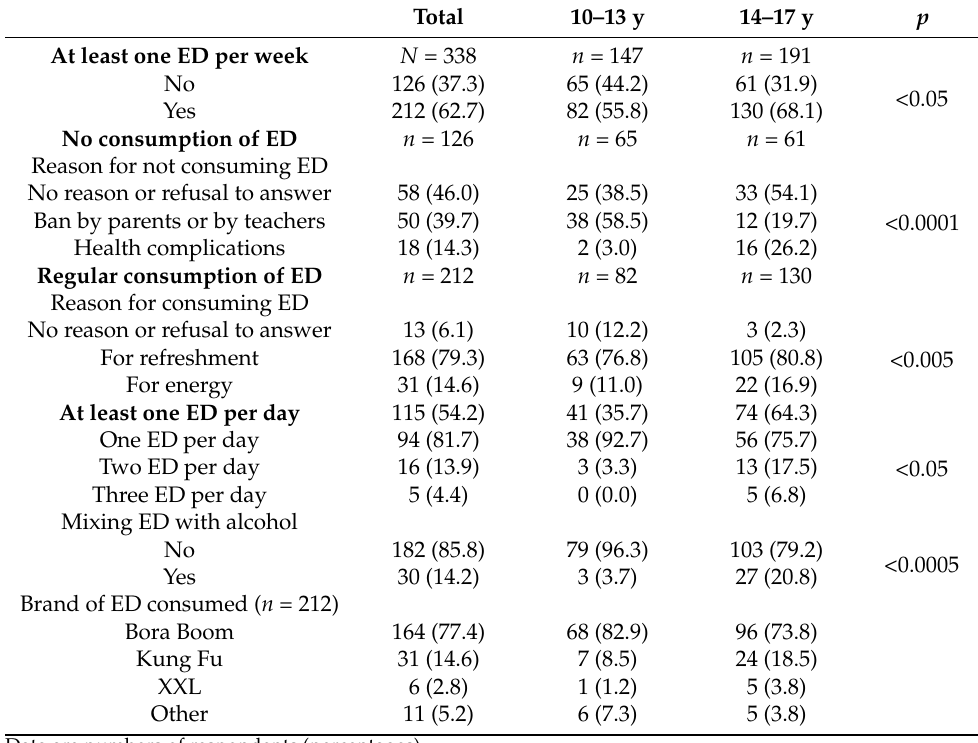
Table 2. Reported consumption of energy drinks (EDs) among pupils participating in a questionnaire survey carried out from 30 May to 7 June 2019 in five schools in Lubumbashi, DR Congo.